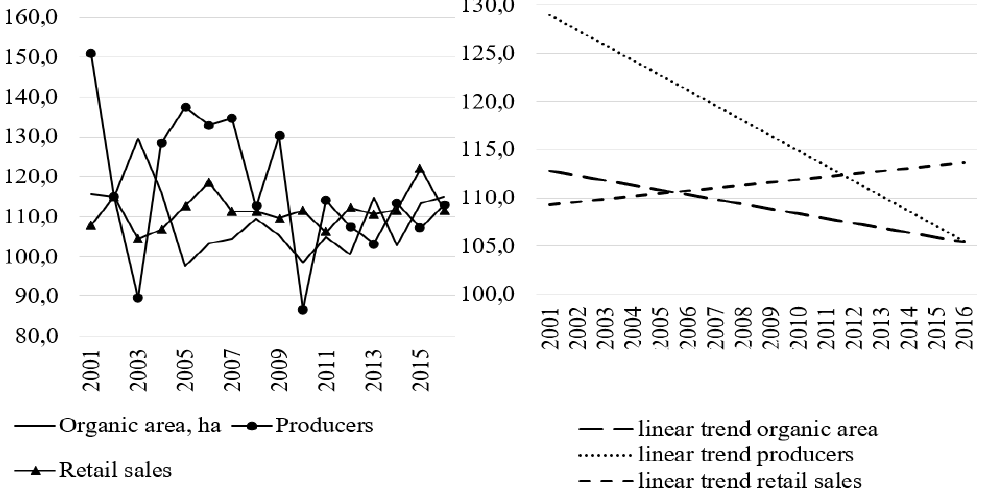
Fig. 1. Growth pace and trends of main indicators of organic products market development in the world Source: Compiled by the author based on the FIBL